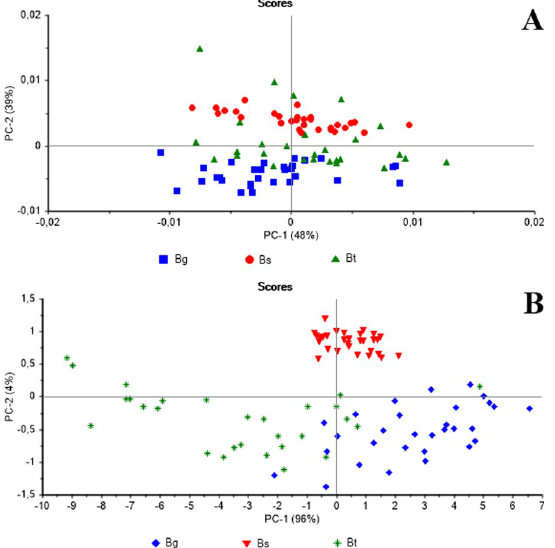
Fig 2. Plots of the principal components scores of the NIR spectra of the Biomphalaria shells dried for 15 days. (A) NIR spectra obtained from the right side of the shell. (B) NIR spectra obtained from the left side of the shell. Bg = Biomphalaria glabrata ; Bt = Biomphalaria tenagophila ; Bs = Biomphalaria straminea .